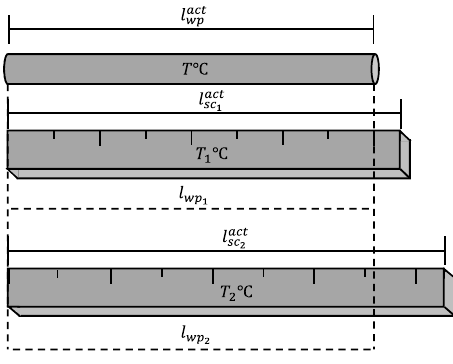
Figure 3. Behavior of the scale at different temperatures.